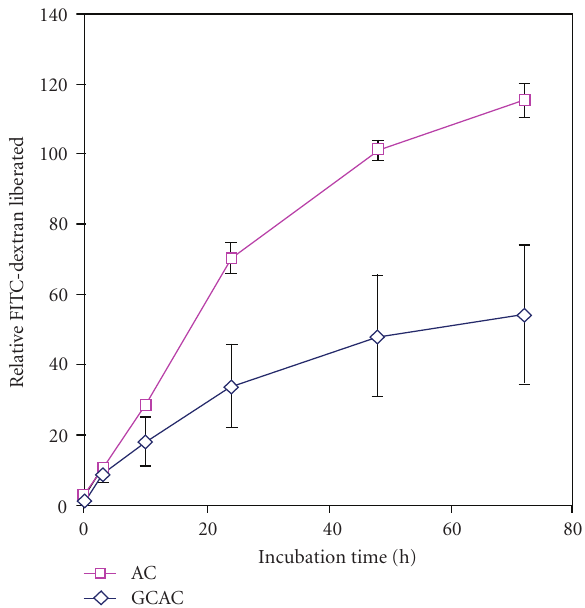
Figure 4: Leaching of the encapsulated FITC-dextran into the simulated intestinal medium following 1 hour simulated gastric exposure. Error bars indicate standard deviation of the mean ( n =